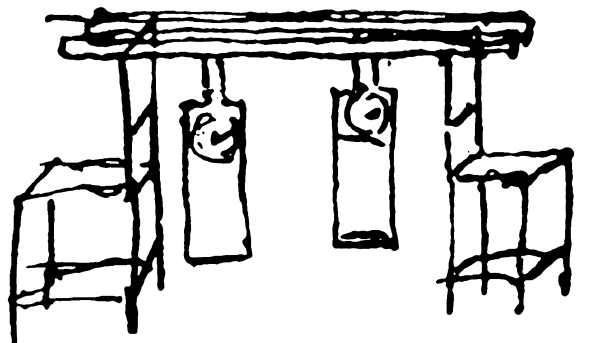
Figure 1. Diagram of Huygens’ experimental device for pendulum synchronization.